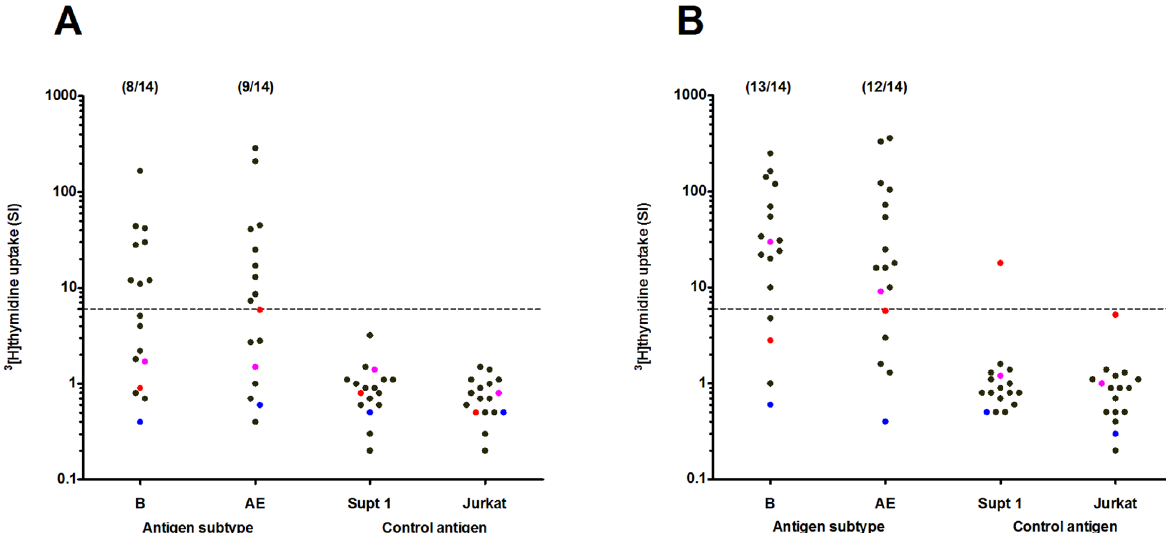
Fig 5. Magnitude of the lymphoproliferative responses. Responses at A) the time of the first CN54rgp140/GLA-AF immunization and B) four weeks after the second CN54rgp140/GLA-AF immunization to AT-2 treated subtype B MN and CRF01_AE antigen and their respective control antigen (Supt1 and Jurkat) are shown. Black dots show vaccinees who received 7 vaccinations and colored dots show volunteers who received two CN54rgp140/GLA-AF immunizations only. The number of vaccinees with a positive lymphoproliferative response per number of tested volunteers are given in parentheses. The Mann-Whitney test was used for statistical